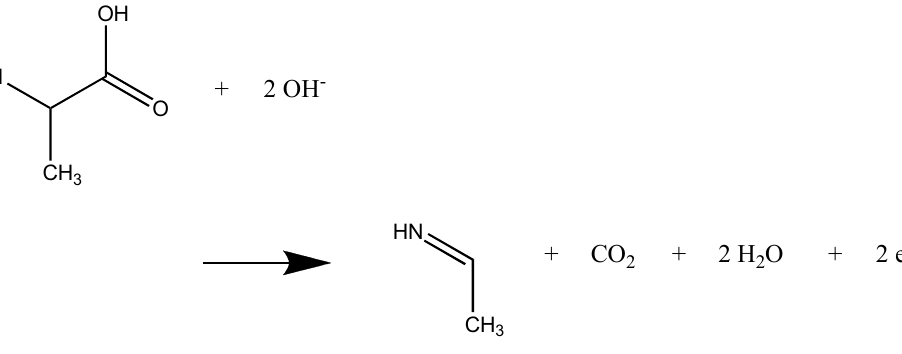
Figure 5. Net reaction of two alanine molecules as observed in the